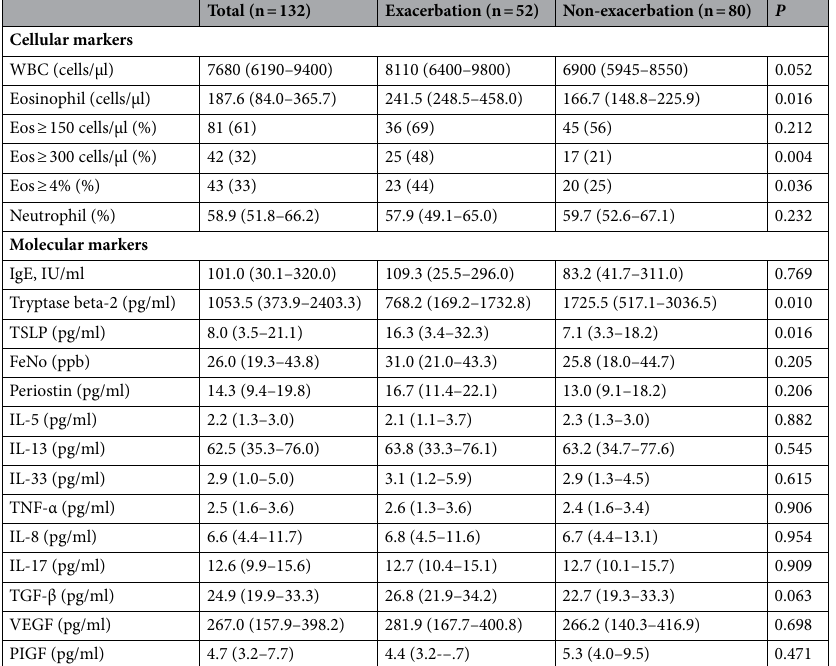
Table 2. Blood cellular and molecular biomarkers in the study subjects (n = 132). Data were reported as median (interquartile range) or number (%). EOS eosinophil, FeNO fraction of exhaled nitric oxide, PIGF placental growth factor, TGF tumor growth factor, TNF tumor necrosis factor, TSLP thymic stromal lymphopoietin, VEGF vascular endothelial growth factor, WBC white blood cell.